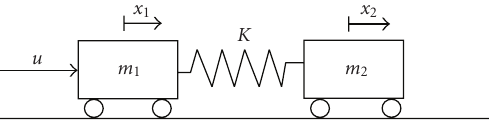
Figure 6: Coupled spring-mass system.